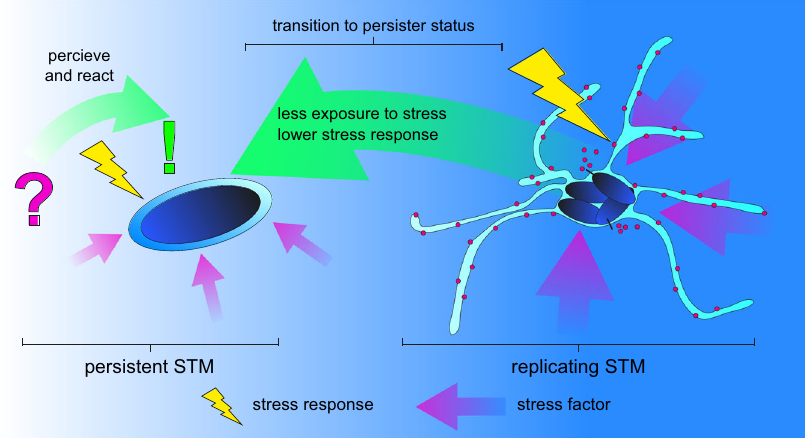
Fig. 7 Transition to persister status results in decreases exposure to stressors and enables survival of harsh conditions in host cells. Replicating intracellular STM show diverse stress responses in reaction to harsh environmental conditions. Intracellular persistent STM are able to sense and respond to stressors by turning on SRS. The induced stress response of persisters is lower compared to the replicating subpopulation of intracellular STM suggesting that persisters encounter lower exposure to stressors. The transition to a persistent state inside host cells promotes stress tolerance, survival, and dissemination of the pathogen due to re-growth after subsidence of stressful